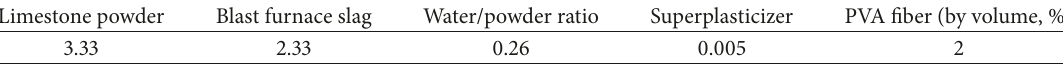
Table 1: Mix proportion of SHCC mix (weight %).